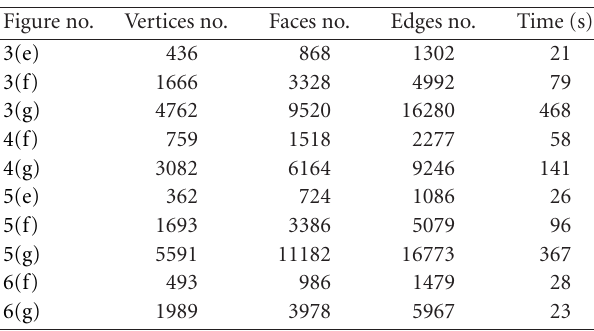
Table 1: Running time information. Figure